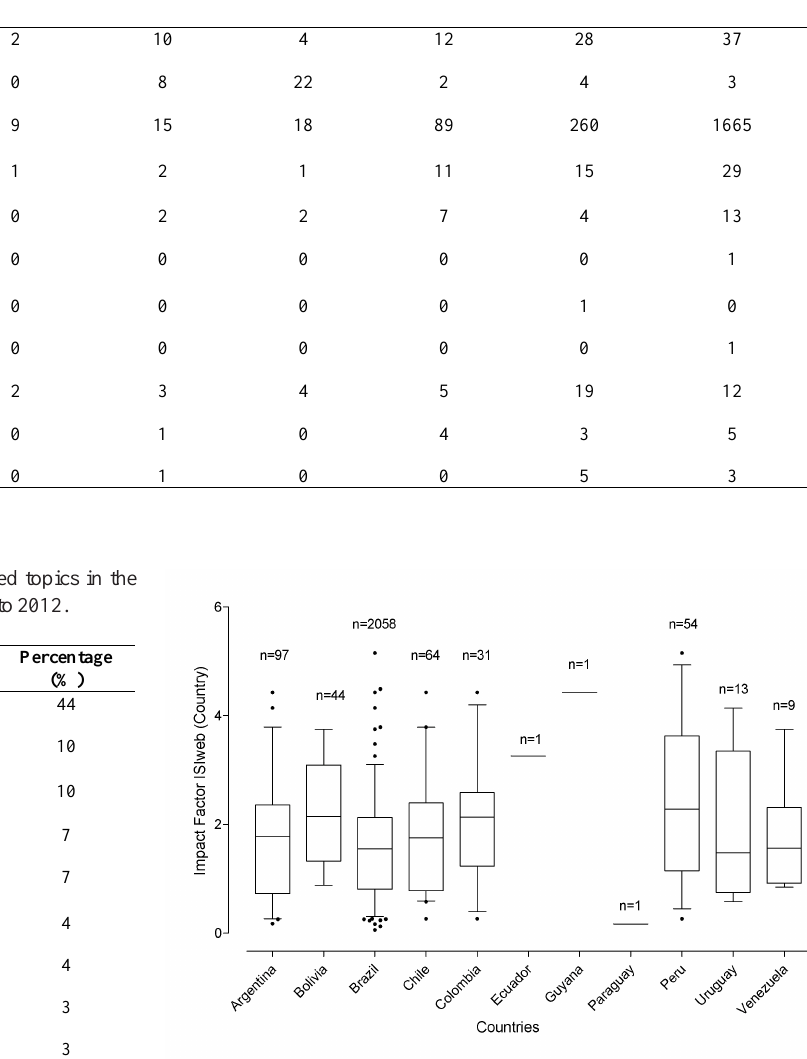
Figure 2. Box and Whisker plots of impact factors of publications in sports science for each country from 1970 to 2012. n = total number of publications per country. The values are expressed in mean, standard deviations, maximum and minimum values of impact